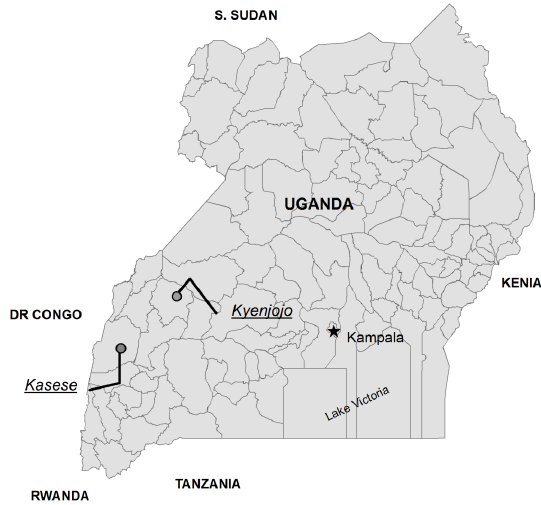
Figure 1. Map of Uganda and districts of interest. Table 1. Differences between the two districts.